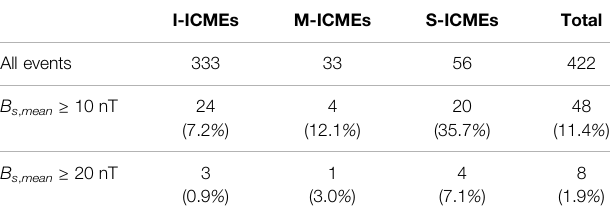
TABLE 1 | The numbers and percentages of ICME groups in different types with strong B s , mean